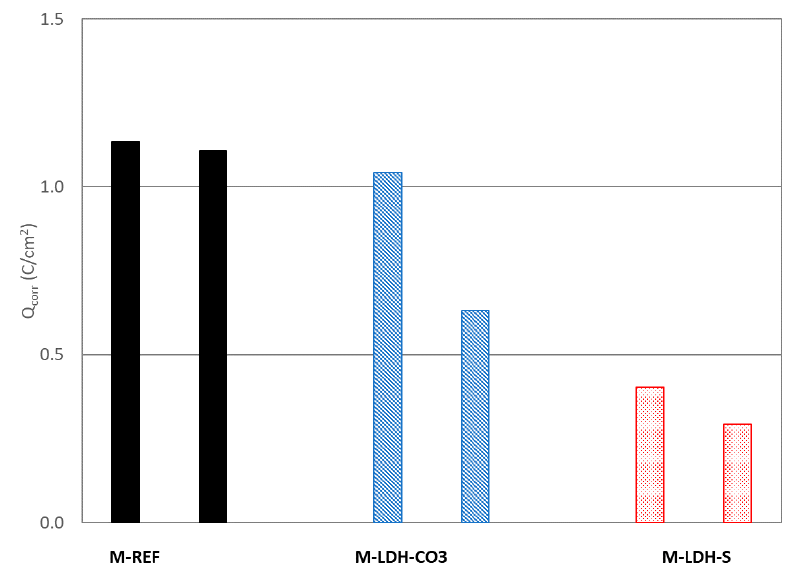
Figure 10. Total charge associated with the corrosion period (exposure to chloride action) for each studied rebar.